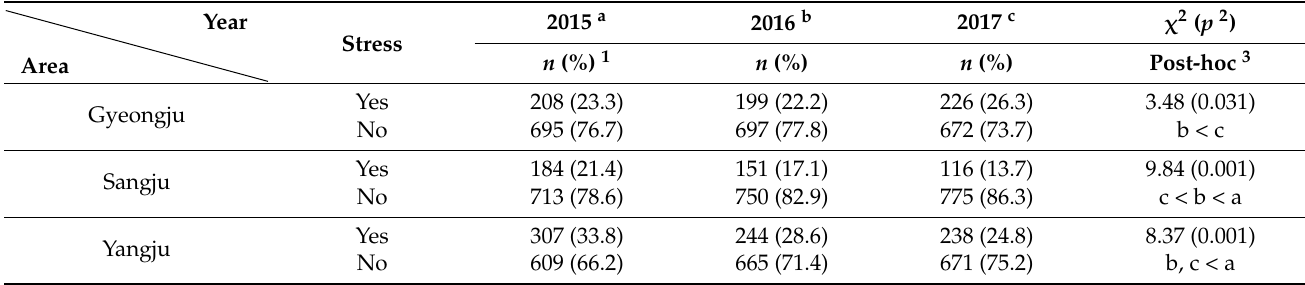
In Table 3, after the earthquake in 2016, the rate of those experiencing depressive symp-